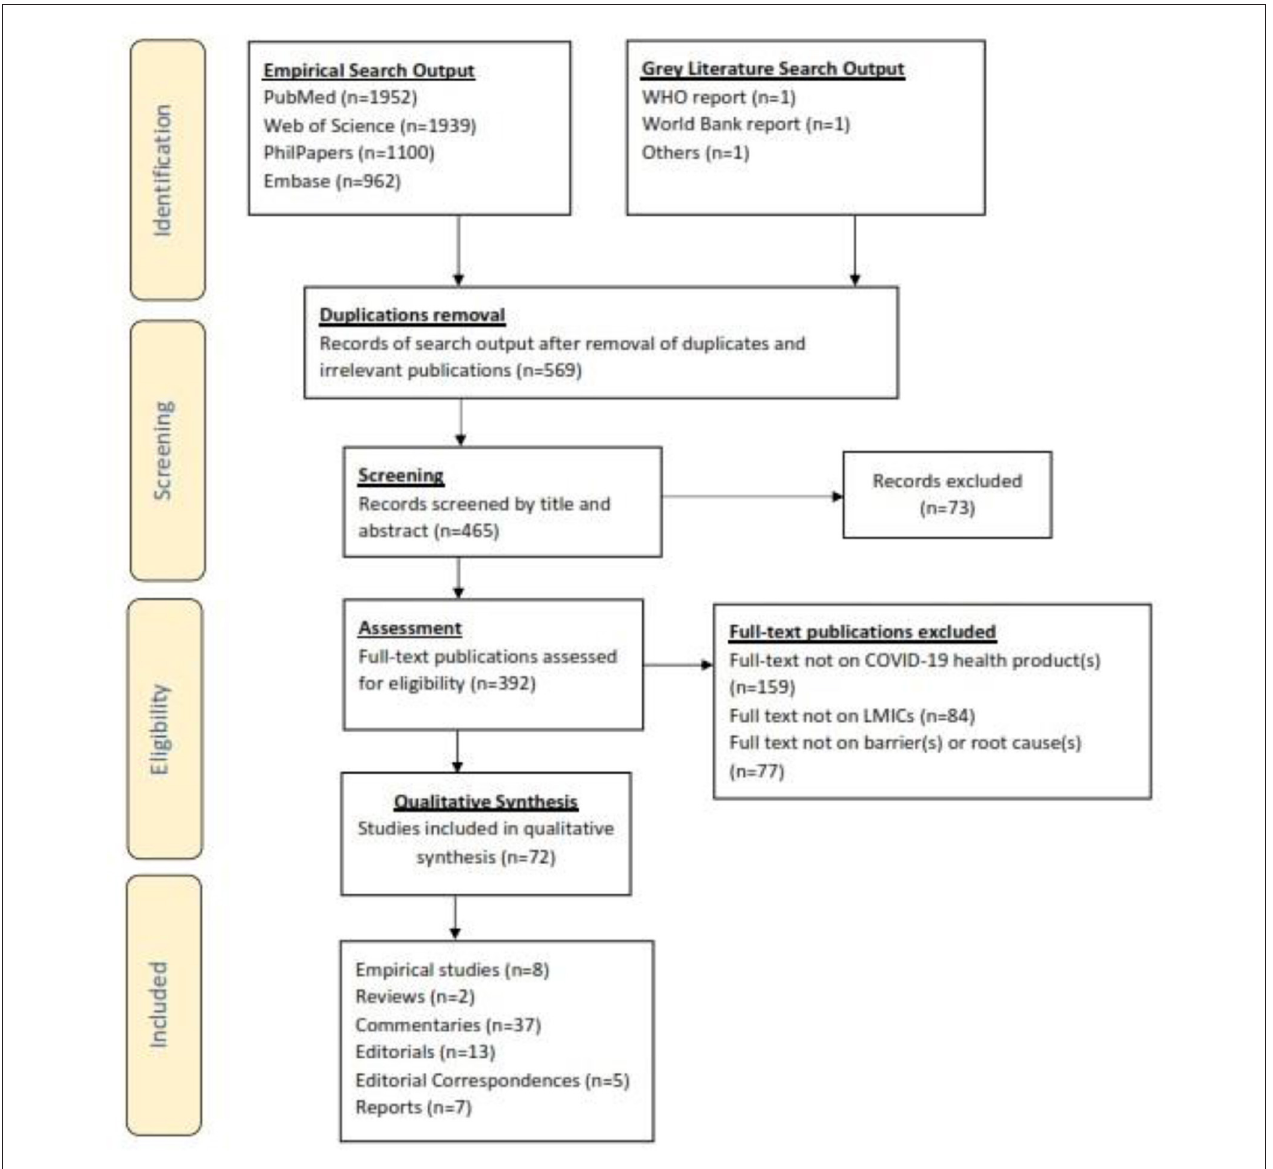
FIGURE 2 | PRISMA-ScR flowchart showing how articles reporting on barriers to COVID-19 health products in low-and middle-income countries during the COVID-19 pandemic were included in the systematic review.